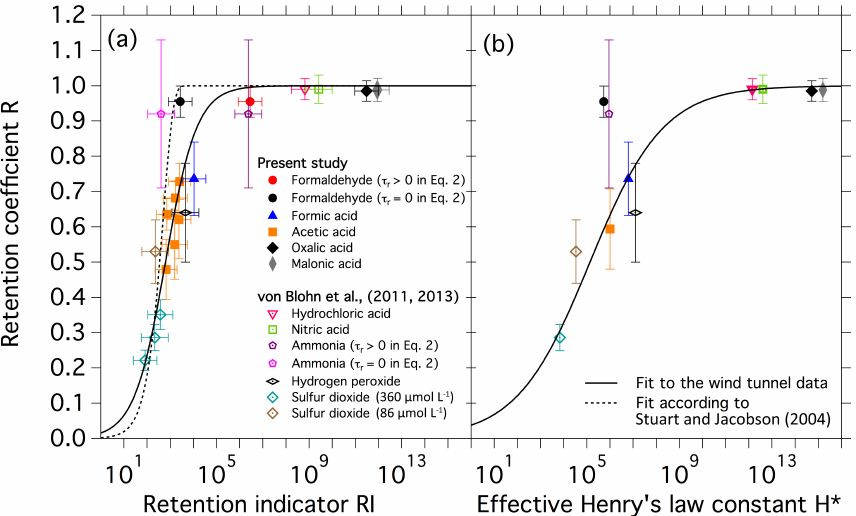
Figure 3. (a) Retention coefficient as a function of retention indicator. Filled symbols: organic substances of the present study. Open symbols: wind tunnel data from earlier studies (von Blohn et al., 2011, 2013). The black filled symbol for formaldehyde and the magenta open symbol for ammonia represent values for equilibrium conditions neglecting the aqueous-phase kinetics (see text for details). Vertical error bars are measurement uncertainties. Horizontal error bars account for the two limits of adiabatic freezing time and total freezing time of the droplets. Dotted line: fit according to Stuart and Jacobson (2004). Solid line: new fit of the wind tunnel data. (b) Retention coefficients as a function of H ∗ . Symbols according to (a) . Solid line: new fit of the wind tunnel data. The H ∗ values are calculated from literature (see Table 4) at given pH and at 0 ◦